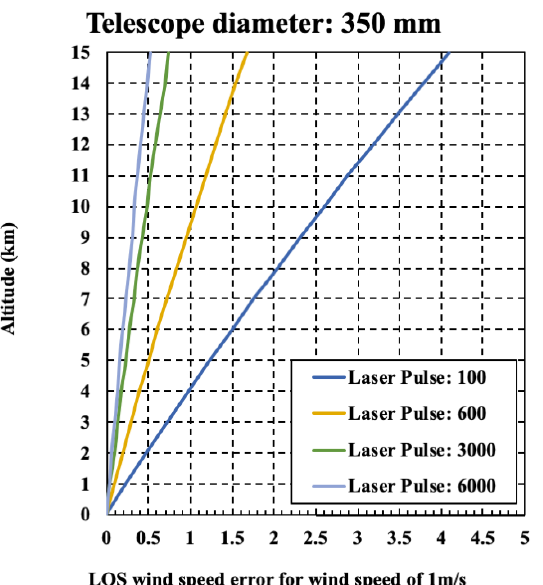
Figure 2. Profiles of the LOS wind speed error for various accumulation laser pulse:100, 600, 3000, and